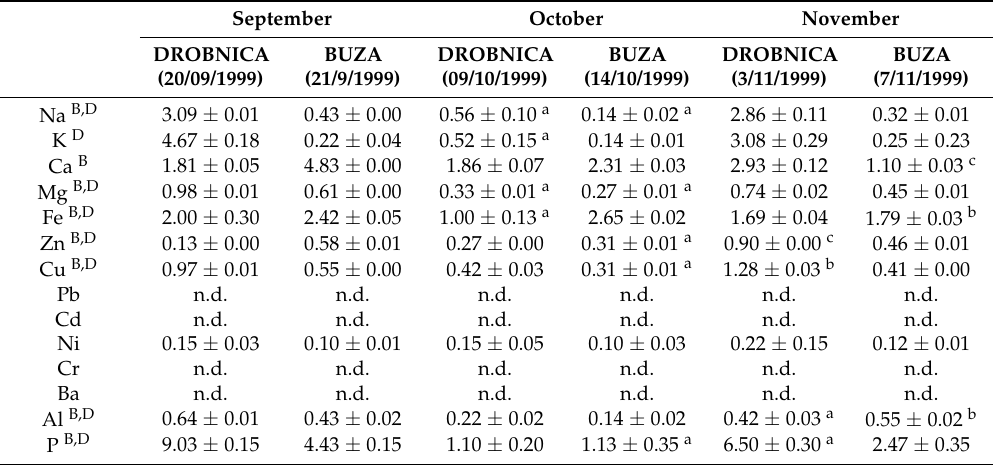
Table 5. Trace minerals in oil extracted from Drobnica and Buza cvs . during fruit